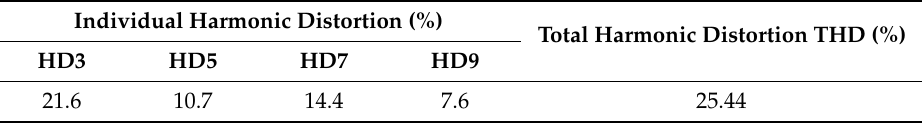
Table 4. Harmonic content of the CS current (maximum limits established by EN-IEC-61000-3-4 for industrial consumers with power < 33 S cc ) for cases C-E.